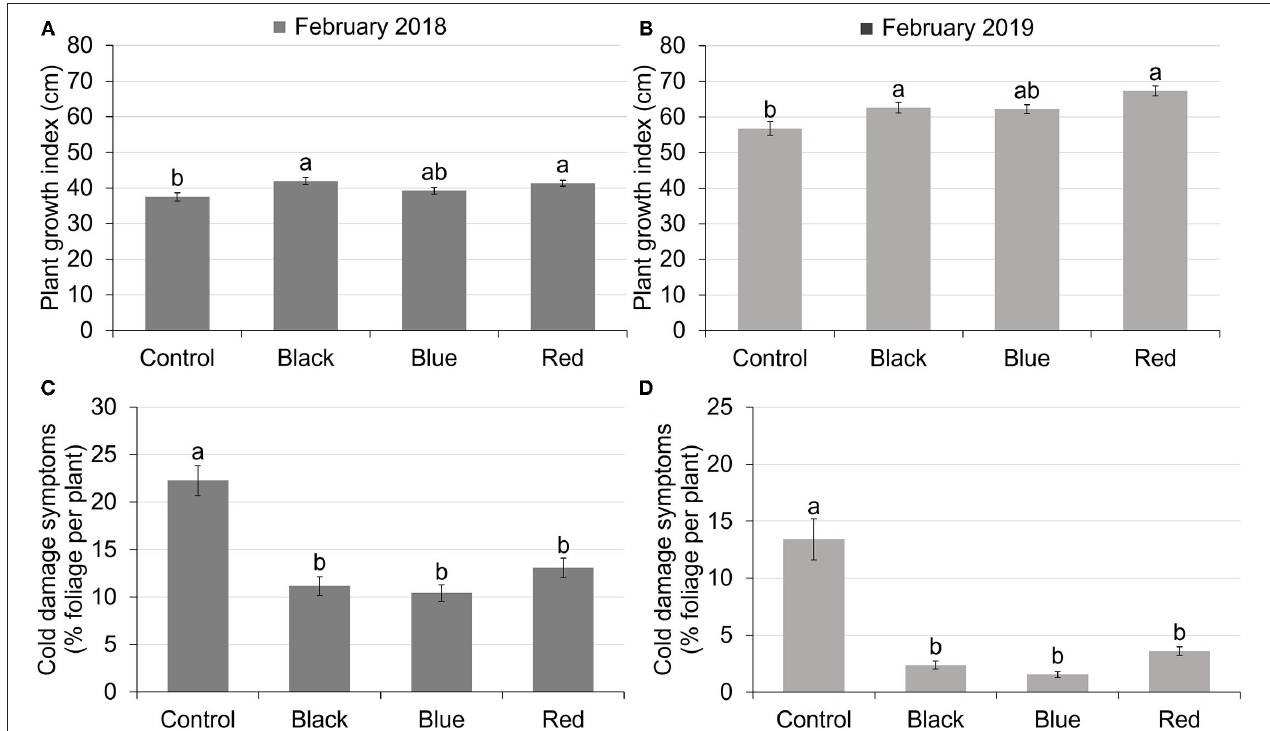
FIGURE 2 | Plant growth index of tea plants in February 2018 (A) and February 2019 (B) under different treatments. Plant growth index was calculated as the average of plant height, width 1 (widest points apart) and width 2 (perpendicular to width 1). The percentage of foliage showing cold-damaged symptoms of tea plants in February 2018 (C) and February 2019 (D) under different treatments. Different letters on top of the columns within each figure represent significant difference between the treatments indicated by Tukey’s honestly significant difference (HSD) test at p ≤ 0.05.